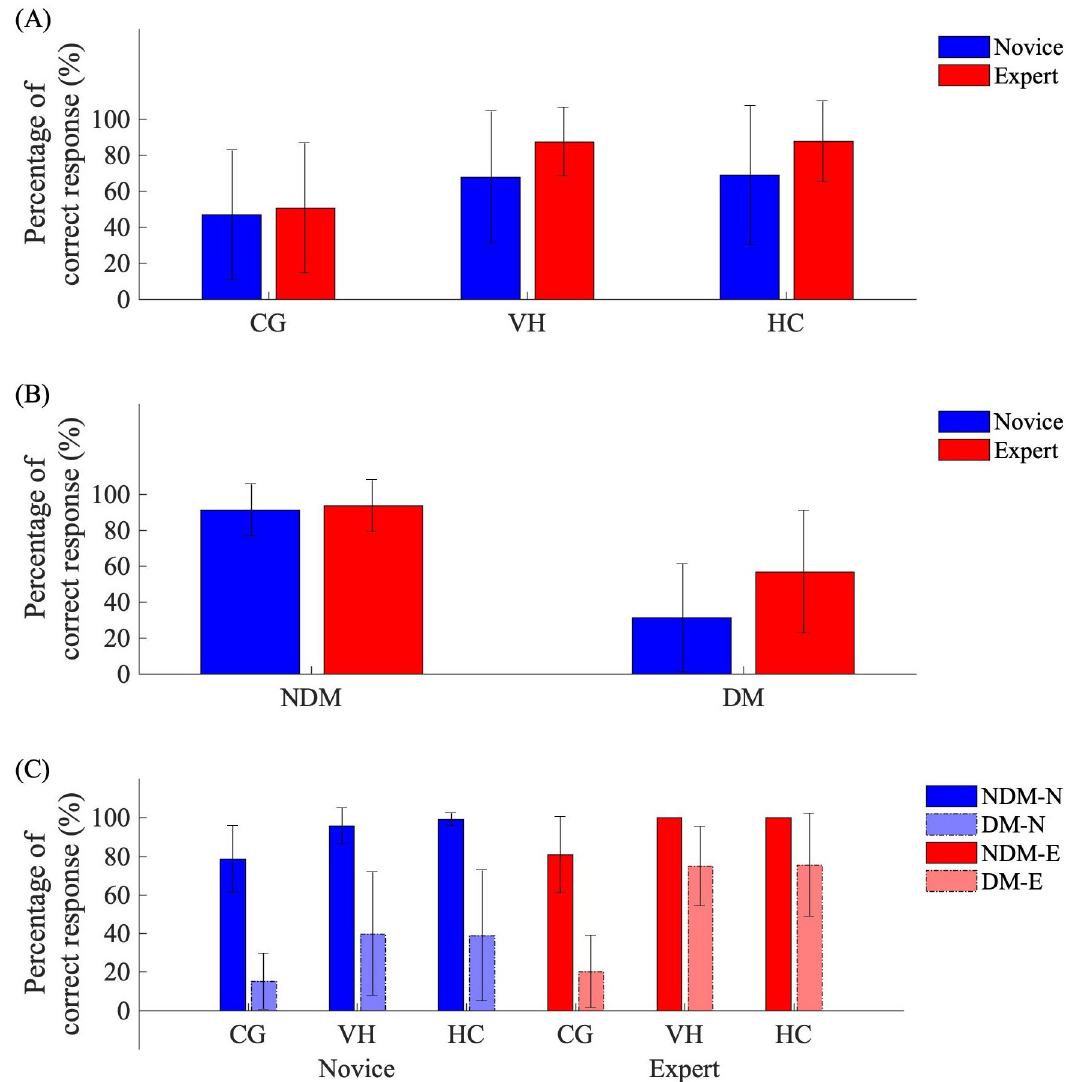
Fig 3. Effect of expertise on rate of success during the perception task. Mean ± SD percentage of success when considering effect of expertise during the perception task, for interactions between level (novices (N) blue and experts (E) red) and appearance (A), motion (DM and NDM) (B), and the interaction between level, appearance and motion (C).